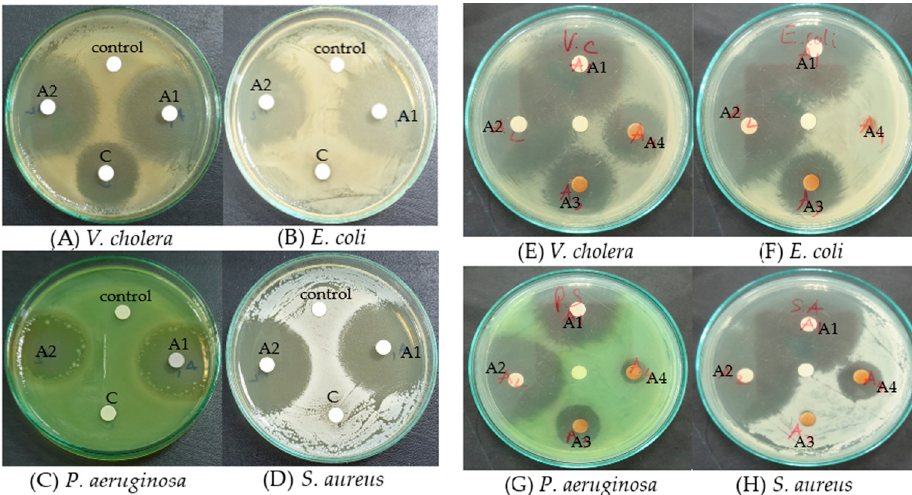
Figure 10. Inhibition zones of ( A ) V. cholera , ( B ) E. coli , ( C ) P. aeruginosa, and ( D ) S. aureus treated with A1 sample (triangular AgNPs 50 μ g/mL synthesized by mixed G(0.2%) + CHI(0.06%) solution at pH